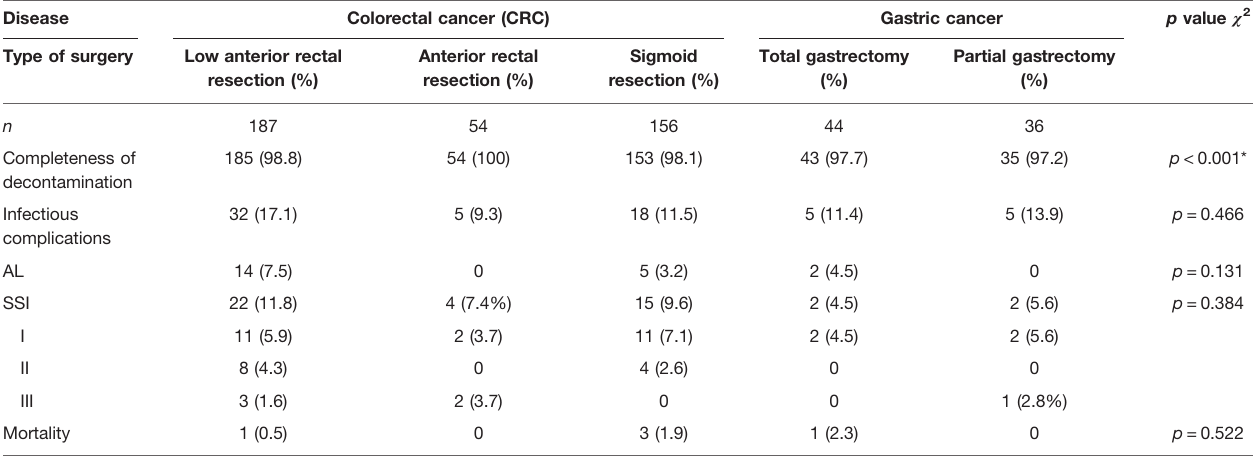
TABLE 3 | Outcome parameters for the type of